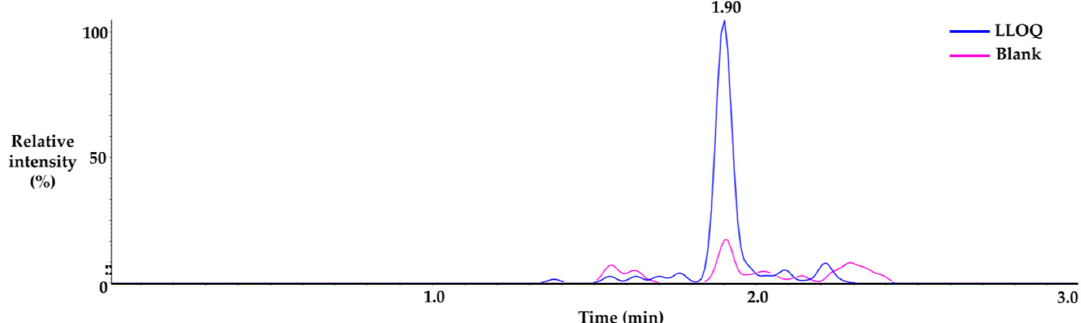
Figure 5. Representative chromatogram of LLOQ and blank sample.